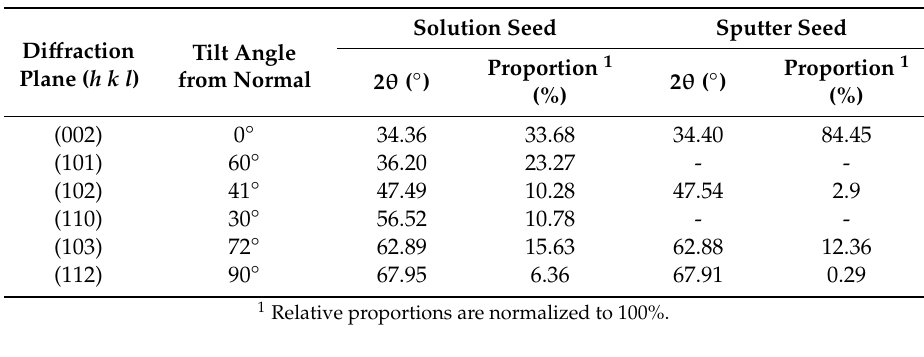
Table 1. Distribution of nanorod angles measured by XRD.